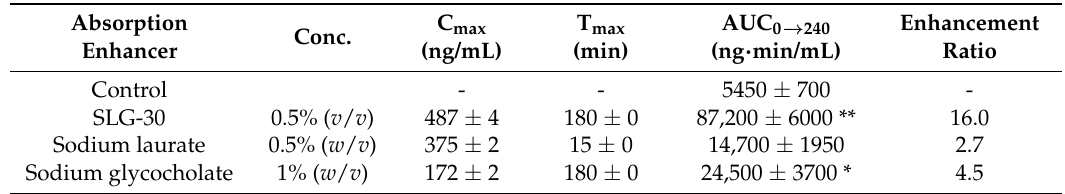
Table 1. A summary of the pharmacokinetic parameters of CF (0.5 mg/kg) after its administration with 0.5% ( v / v ) SLG-30, 0.5% ( w / v ) sodium laurate, and 1% ( w / v ) sodium glycocholate into rat small intestines by an in situ closed-loop